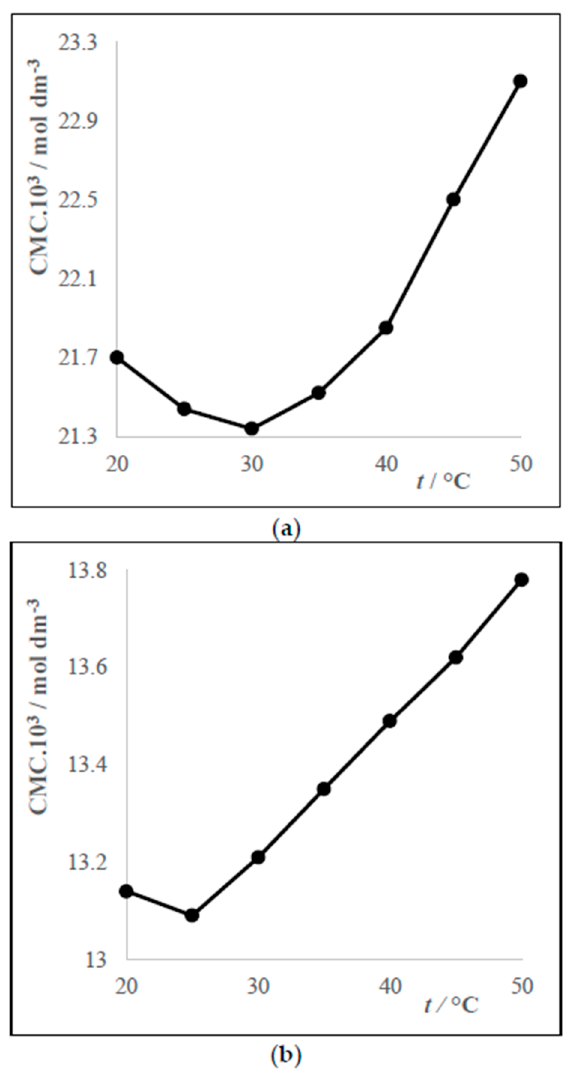
Figure 4. Dependences CMC = f ( t ) for systems DDTMACl (II)–water with minimum at 30 °C—part ( a ) and system DDEDMABr (IV)–water with minimum at 25 °C—part ( b ). The CMCs are different despite the molecule have the same C12 hydrophobic group. The hydrophilic group causes changes of the CMC. This dependence is given in Figure 5.